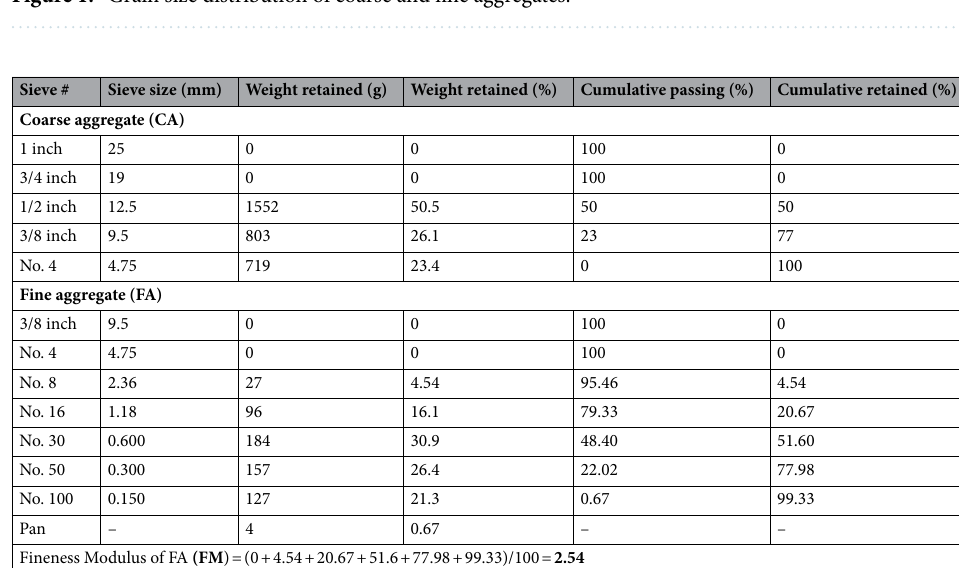
Figure 1. Grain size distribution of coarse and fine aggregates.